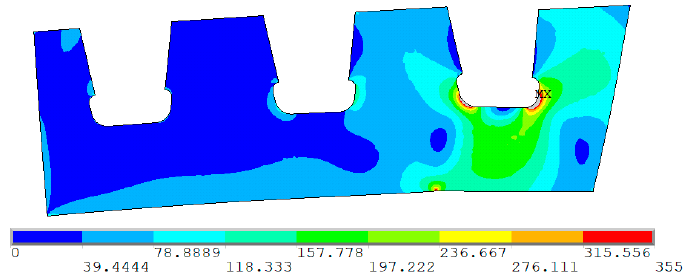
Figure 7. von Mises stress distribution on the cross-girder scaled to the yield strength (units in (MPa)).